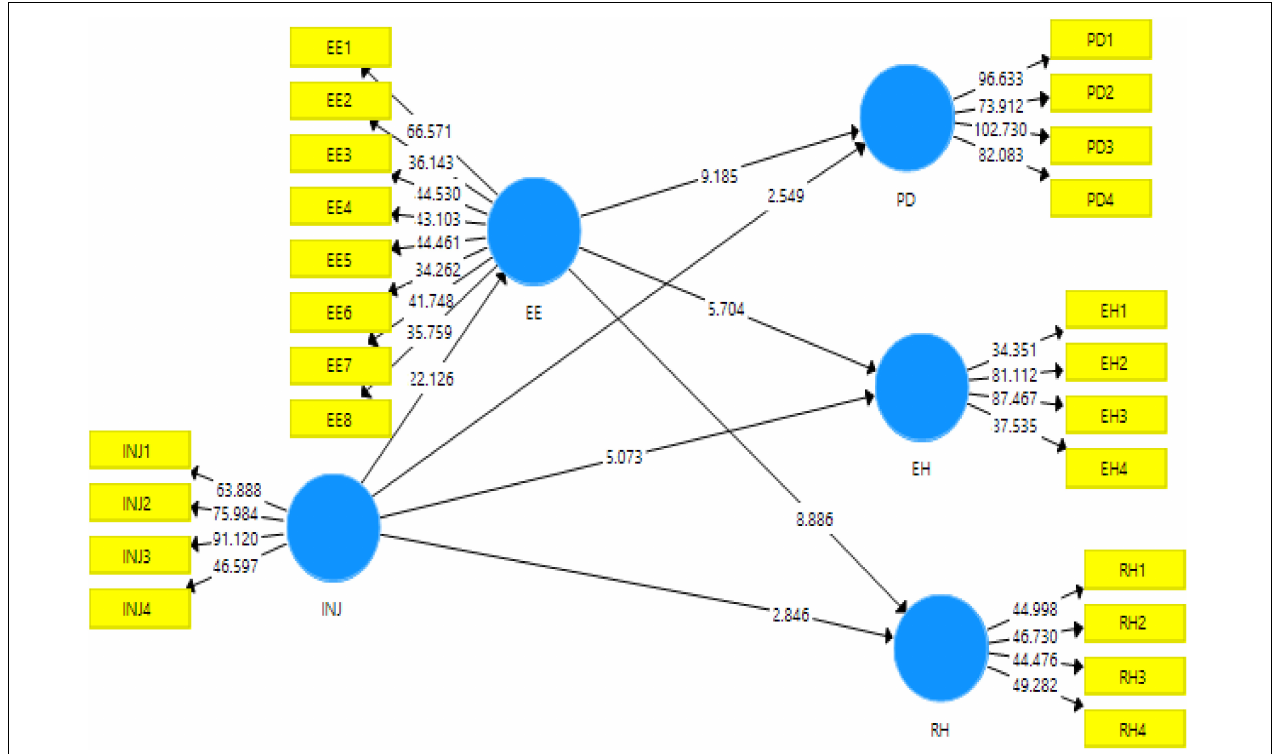
FIGURE 3 | Structural model without moderation. INJ, interpersonal justice; EE, emotional exhaustion; EH, evasive hiding; PD, playing dumb; RH, rationalized hiding; WS, high-performance work stress.